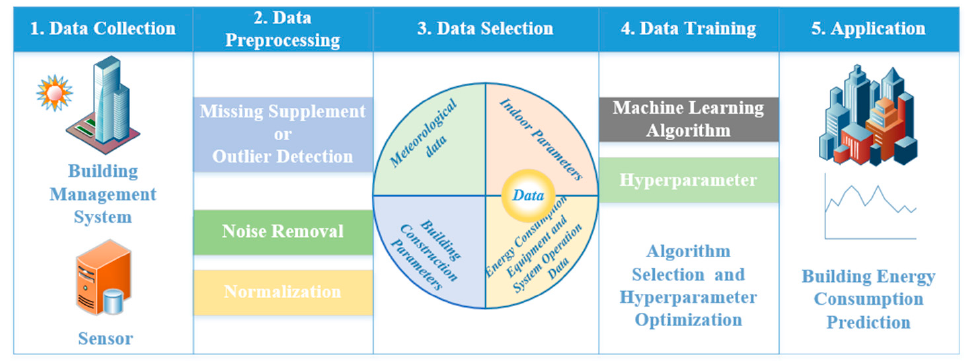
Figure 2. Data-driven method process in BECP.